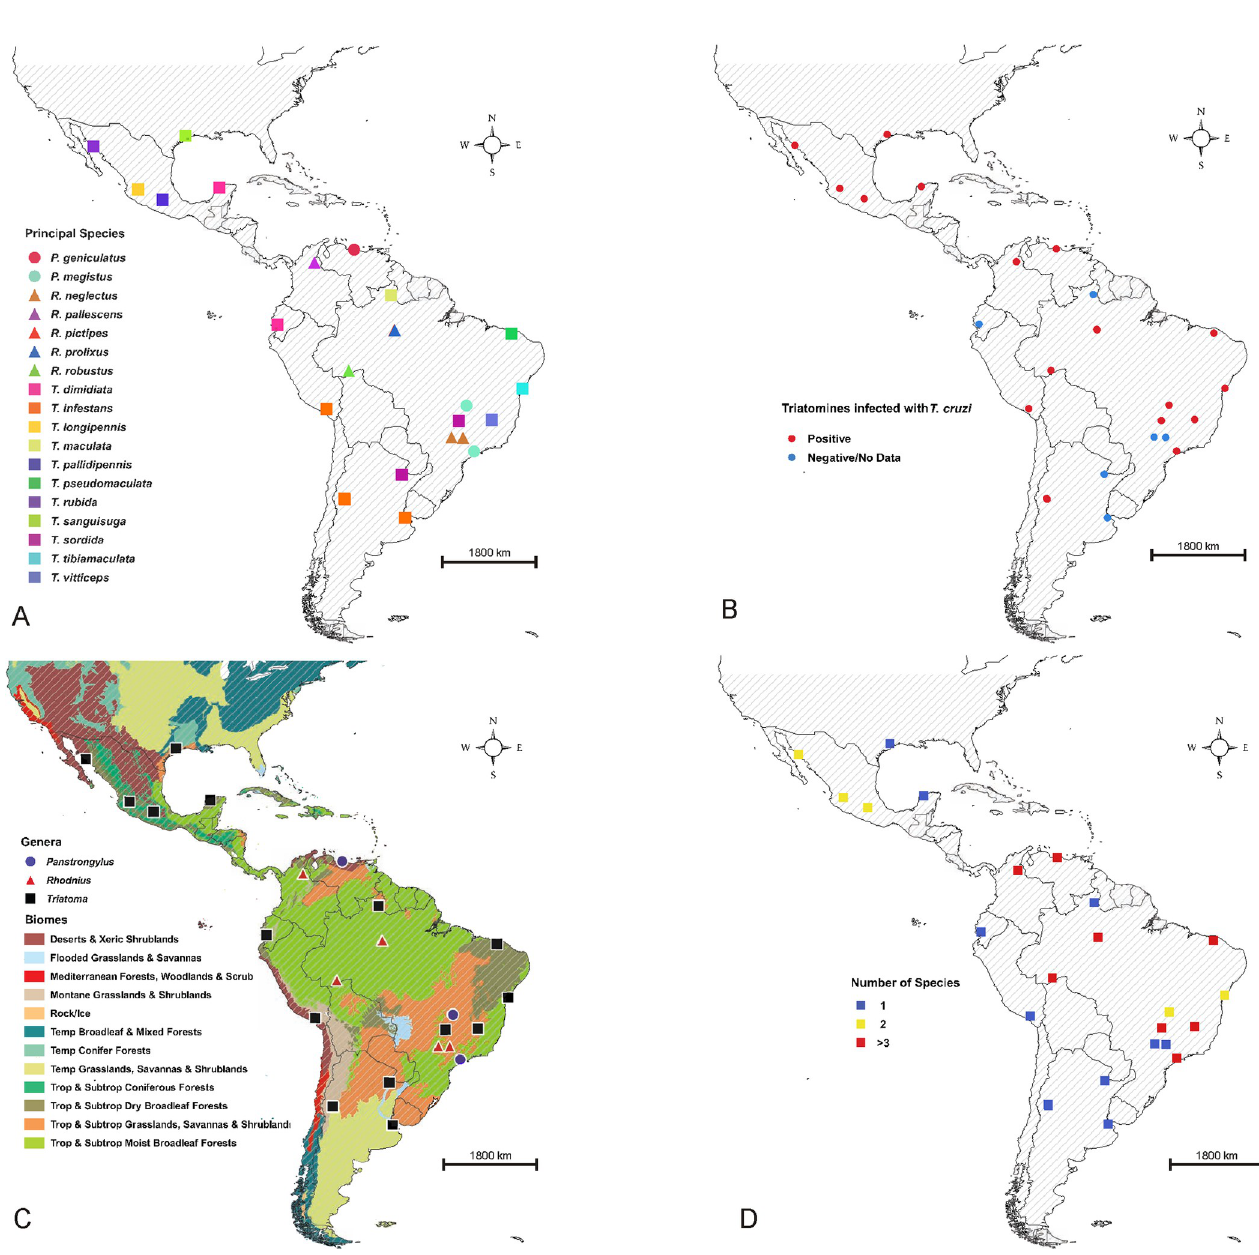
Fig 3. Geographical-ecological coverage of studies on occurrence of urban triatomines. A) Records of the main species that inhabit large urban agglomerates; B) Vectors infected with Trypanosoma cruzi ; C) Biomes in which the three main genera of epidemiological importance have been reported; D) Records where several species have been reported. Maps were generated using the free open source geographic information system software QGIS Girona 3.0 free access program (QGIS Development Team 2018, https://www.qgis.org/es/site/); the shape files of the WWF Terrestrial Ecoregions of the World are freely available from https://www.worldwildlife.org/publications/terrestrial-ecoregions-of-the-world and the shape file of the Neotropical countries outlines are freely available at http://www.efrainmaps.es (Carlos Efraı´n Porto Tapique´n. Geografı´a, SIG y Cartografı´a Digital. Valencia, Espa ñ a, 2020).